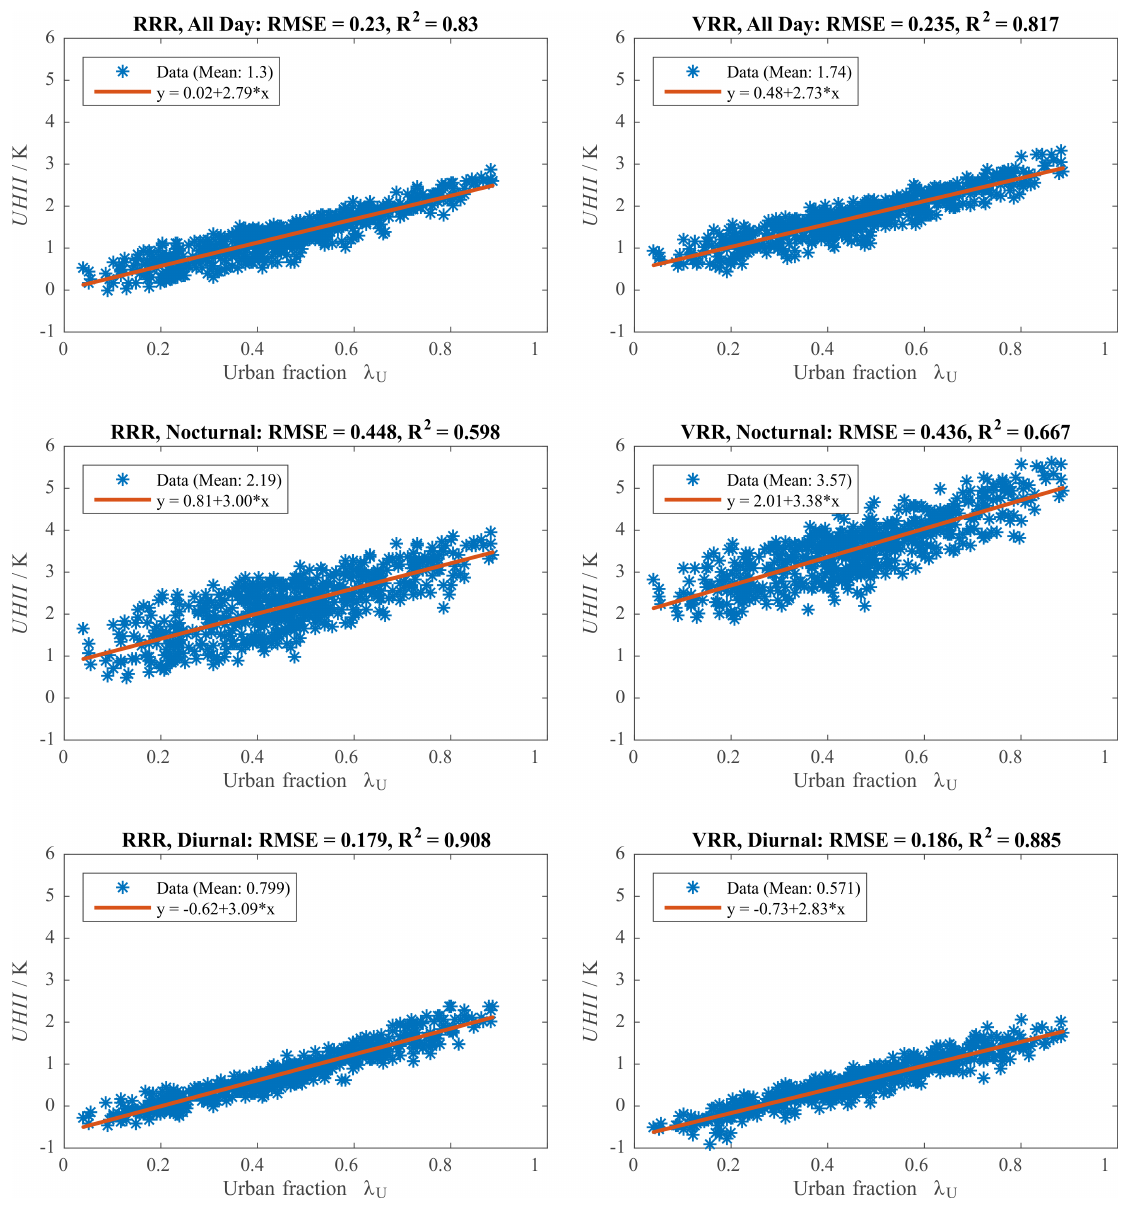
Figure 9. Linear regression correlating UHII with urban fraction (left column: RRR, right column: